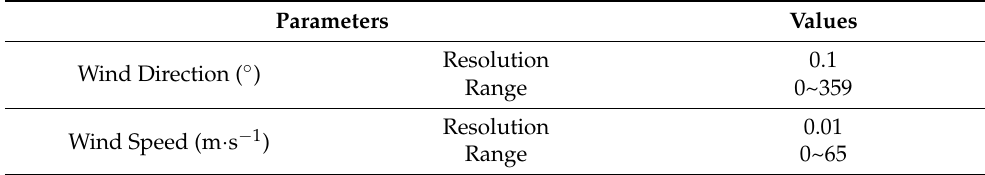
Table 1. Instrument parameters.